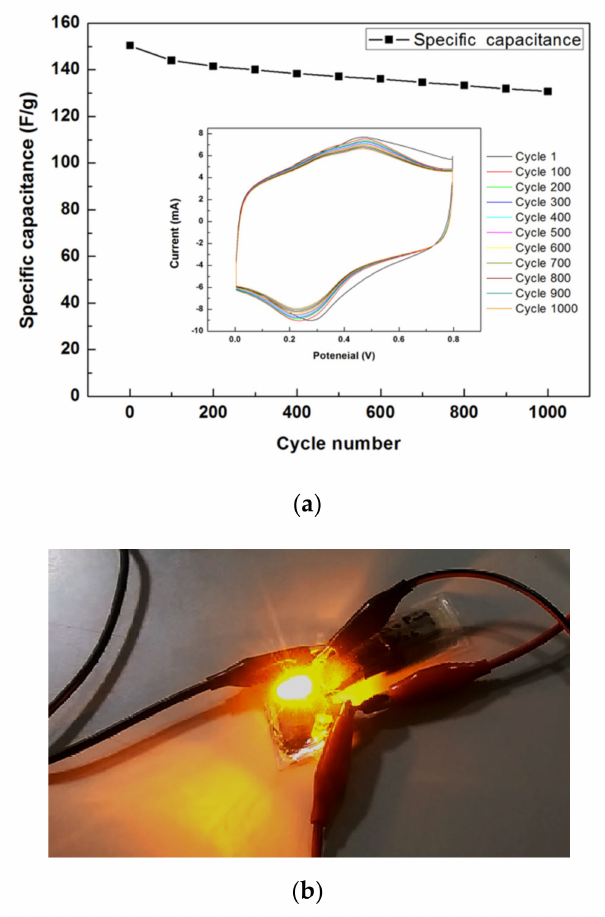
Figure 11. ( a ) 1000-cycle CV cycling stability test of rGO / PANI supercapacitor and ( b ) A LED powered by a charged rGO / PANI supercapacitor with APPJ-modified graphite